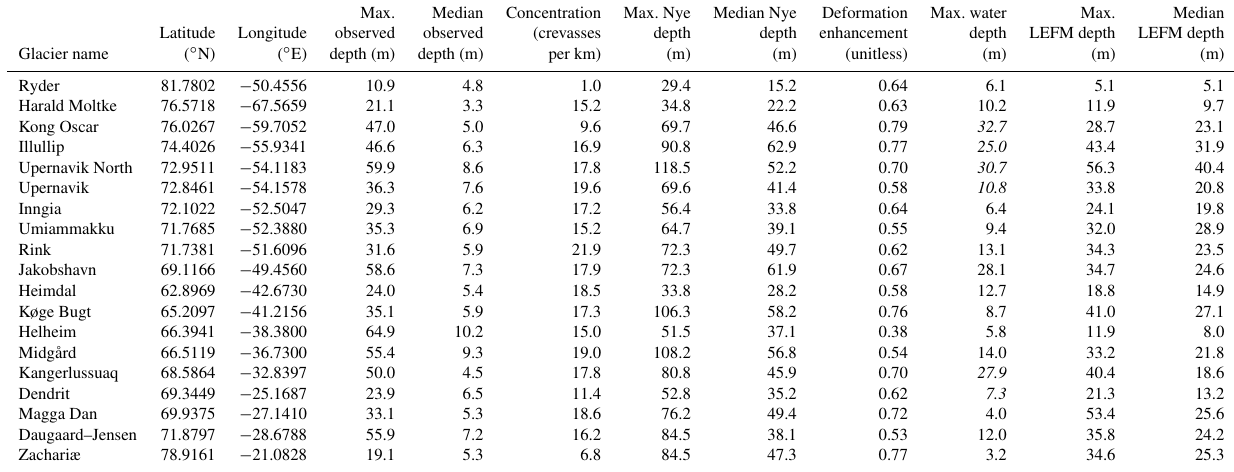
Table 1. Observed and modeled crevasse characteristics within 5km of the terminus. The name, location, maximum and median observed crevasse depths, median concentration of crevasses, maximum and median Nye-modeled crevasse depths, median tuned deformation en- hancement factor, maximum tuned water depth, and maximum and median LEFM-modeled crevasse depths for each study site.